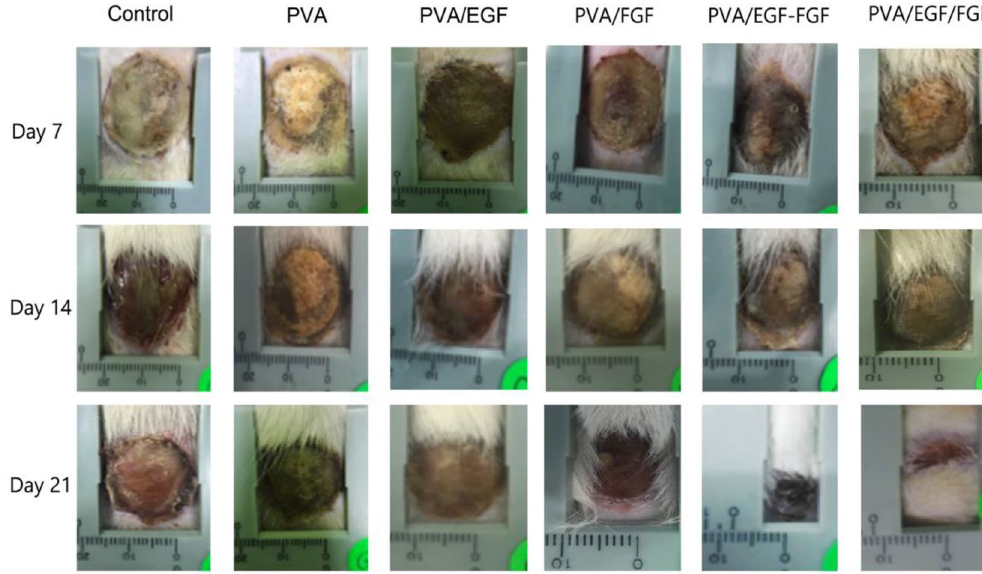
Figure 9. Wound closure rate of fill thickness burn wound treated with various nanofibers.